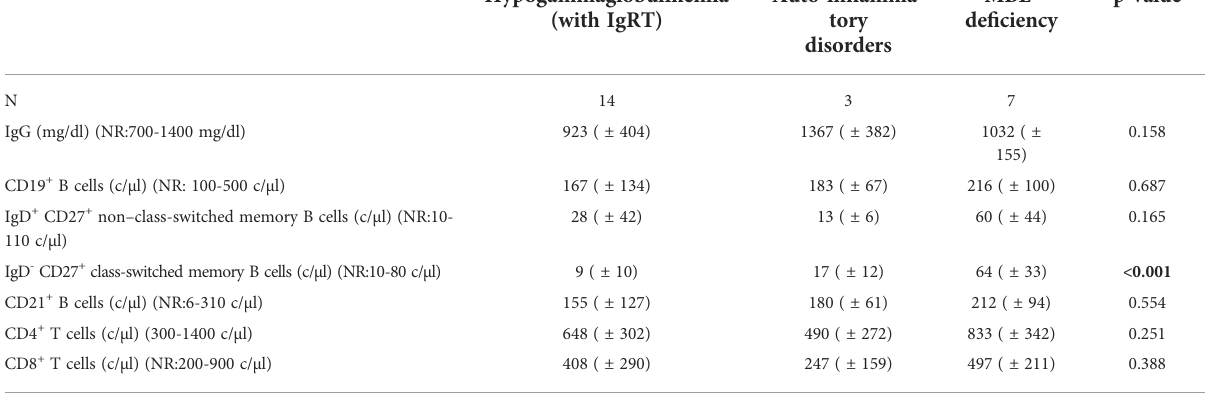
TABLE 2 Comparative analysis of serological and cellular data of patients with hypogammaglobulinemia (with IgRT), autoin fl ammatory disorders and MBL-de fi